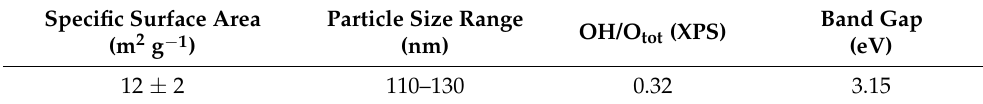
Table 4. Features of the TiO 2 used as support.